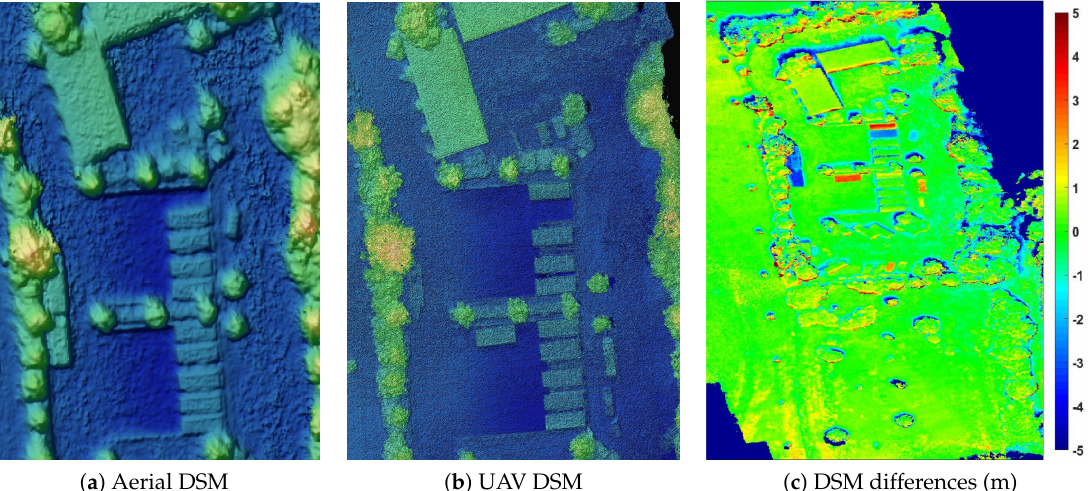
Figure 16. Comparison of ( a ) aerial and ( b ) UAV DSM of the Germering dataset. 20-cm GSD for aerial and 2-cm GSD for UAV DSM. ( c ) Color map illustrating the height differences between the two DSMs in